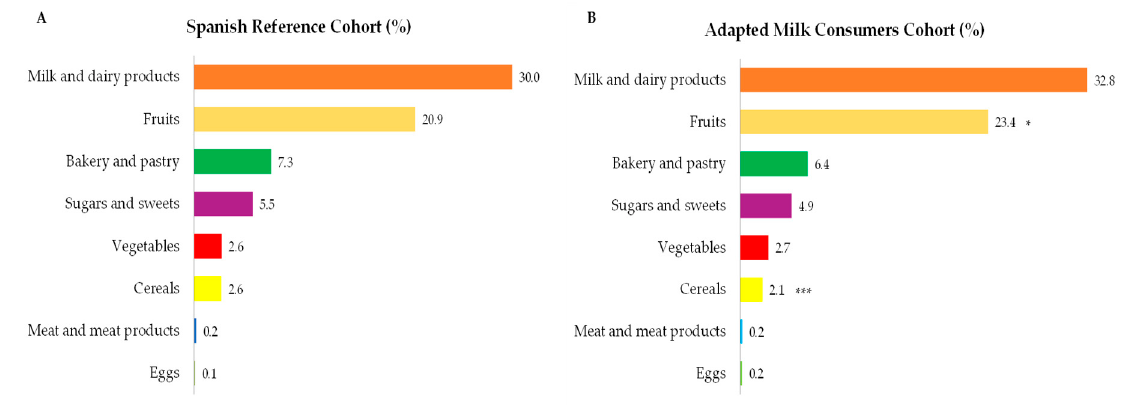
Figure 4 . Dietary food and beverage groups contributing to total sugar intakes (%) from the EsNuPI study population (“Spanish Pediatric Population”) in both Spanish Reference Cohort ( A ) and the Adapted Milk Consumers Cohort ( B ). * p ≤ 0.05 compared to reference cohort (Mann-Whitney test). *** p ≤ 0.001 compared to reference cohort (Mann-Whitney test). Only foods contributing ≥ 0.1% to total carbohydrates intakes of the population have been included.